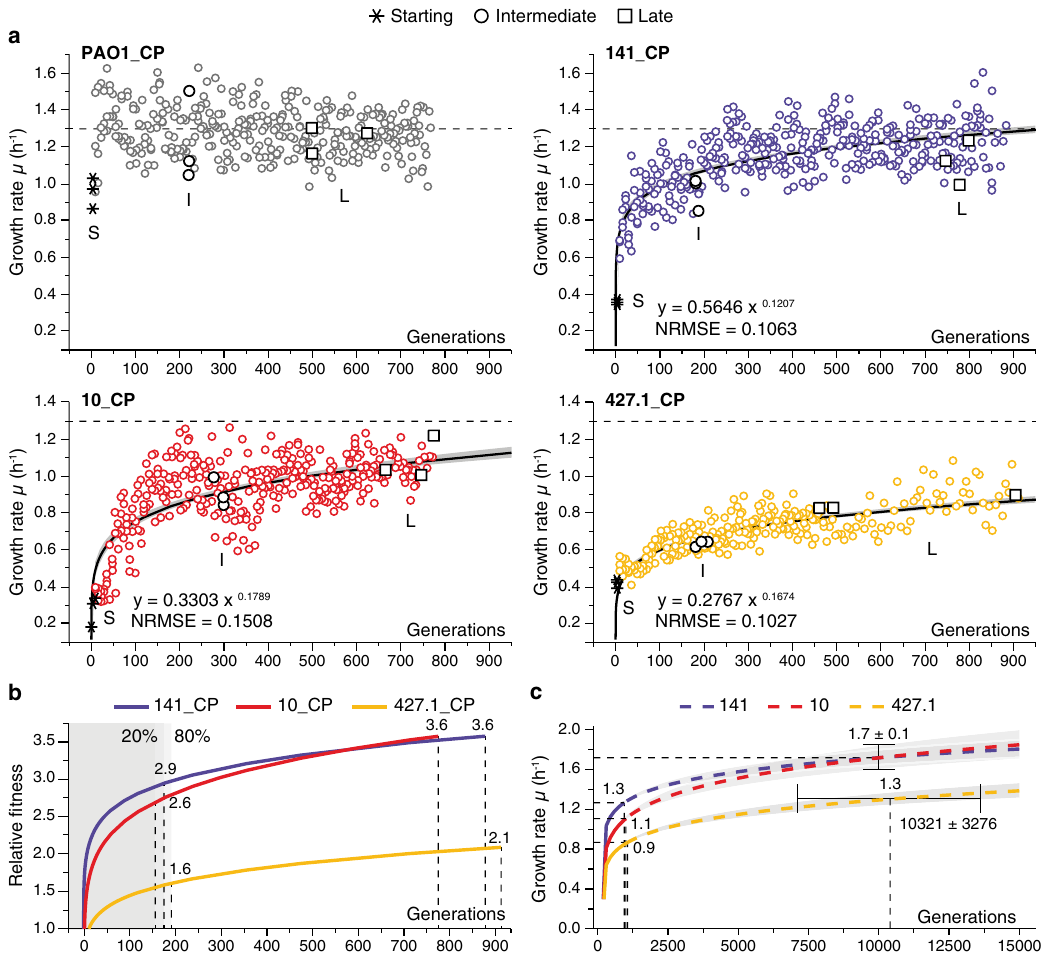
Fig. 1 Fitness trajectories of evolving Pseudomonas aeruginosa populations. a The plots represent the increase in growth rate of the combined populations (CP) constituted by merging the data of three independent populations evolved in parallel from each starting strain PAO1_S, 141_S, 10_S and 427.1_S (see Supplementary Fig. 2 for each independent population). The dots represent the growth rate of each population during ALE. The asterisks represent the growth rate of each starting (S) strain. The black circles and squares indicate the populations from which single colonies were isolated and further analyzed. The black curves show the fi t of a power-law model and the grey shaded area the 95% con fi dence limits. The models, including the normalized root-mean-square error (NRMSE), are indicated in each plot. b Relative fi tness observed in the CP. The average fi tness increase of each CP was calculated relative to the growth rate of the starting S strains using the power-law model. The fi tness at 20 and 80% of generations is indicated in the plot. c Growth rate increase prediction for the evolving populations. The continuous lines show the fi tness trajectories determined using the experimental data as in panel a , while the dashed lines show the simulated posterior distribution of the growth rate according to the power-law models for each CP. The grey shaded areas and black bars show the 95% con fi dence limits of the predictions. Source data are provided as a Source Data fi